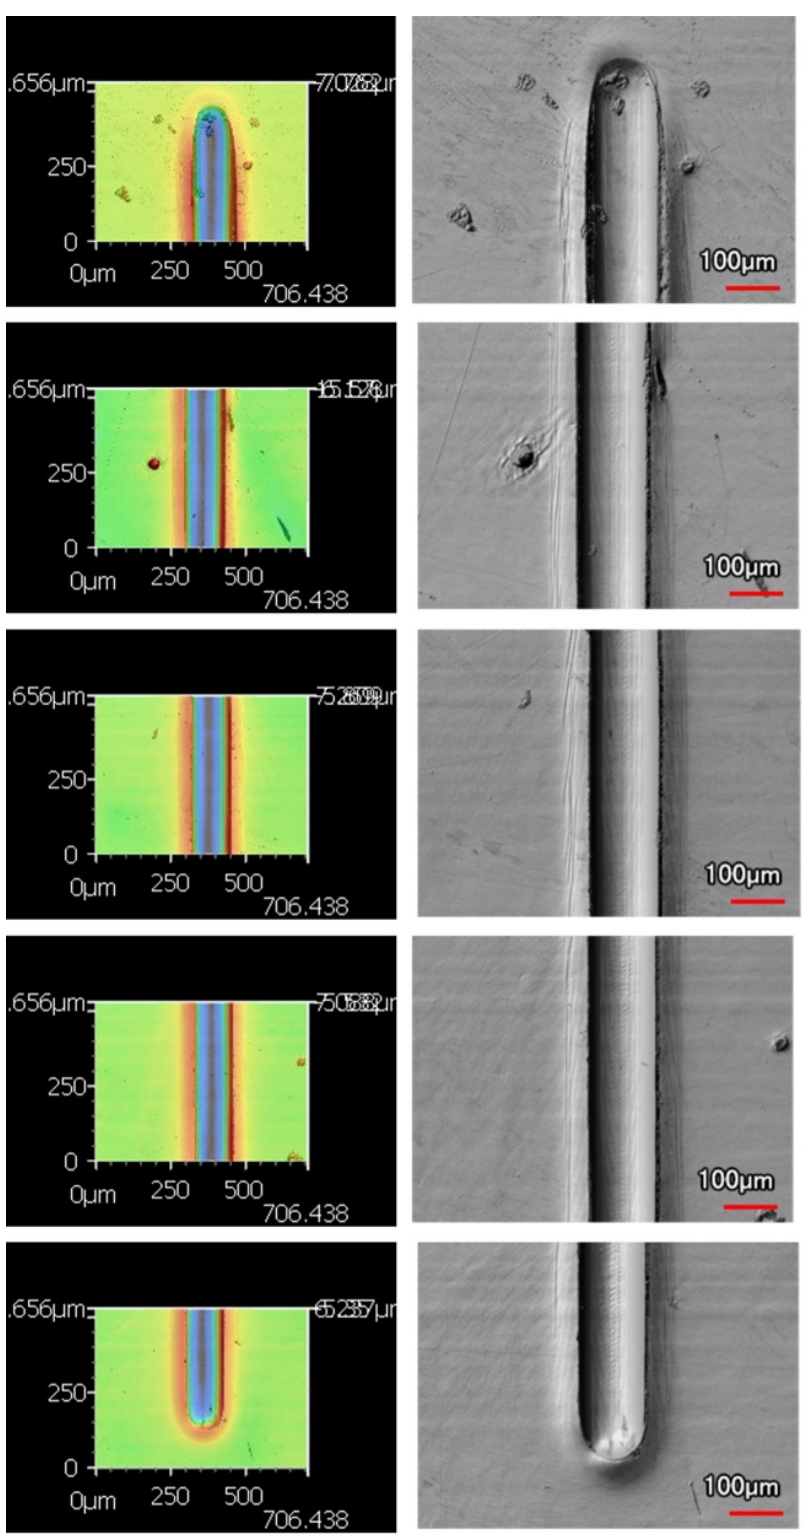
Figure 8. Micrographs of Wear Track from 50 Passes of the Sharp Indenter on 9 µ m Thick Ni-P Coating.